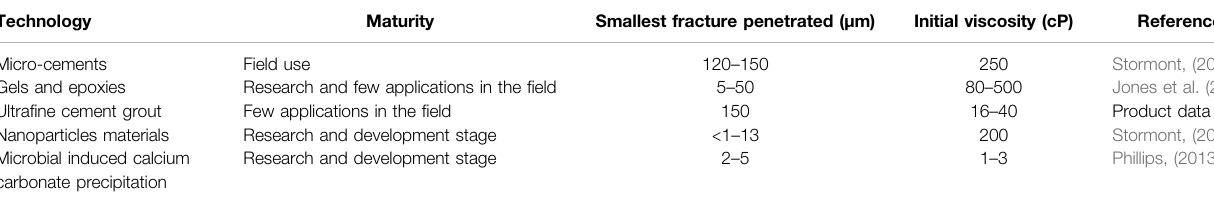
TABLE 1 | Different techniques used for plugging